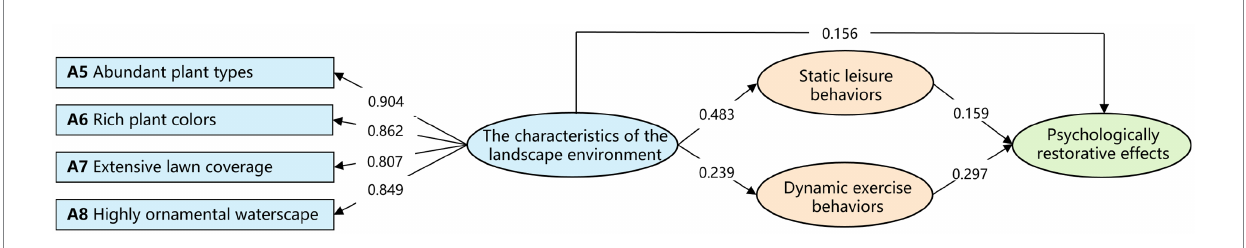
FIGURE 8 Influence effect illustration of the characteristics of the landscape